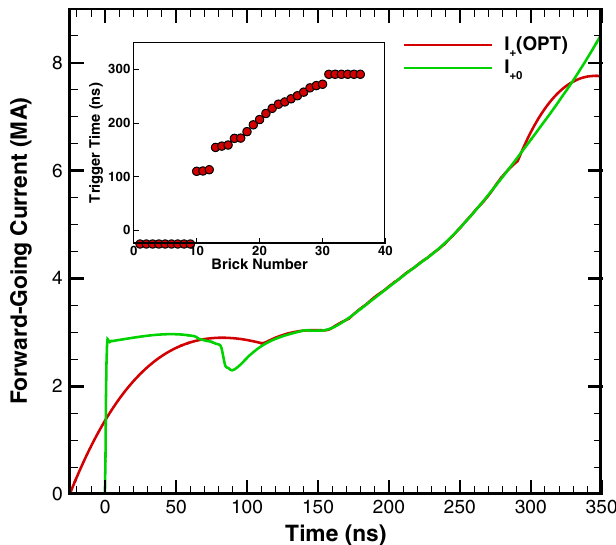
FIG. 17. Optimized fit for forward-going current compared to desired forward-going current. Inset shows trigger times ( τ ) for 100 GPa Cu compression example with 36 independent trigger times and 288 bricks.